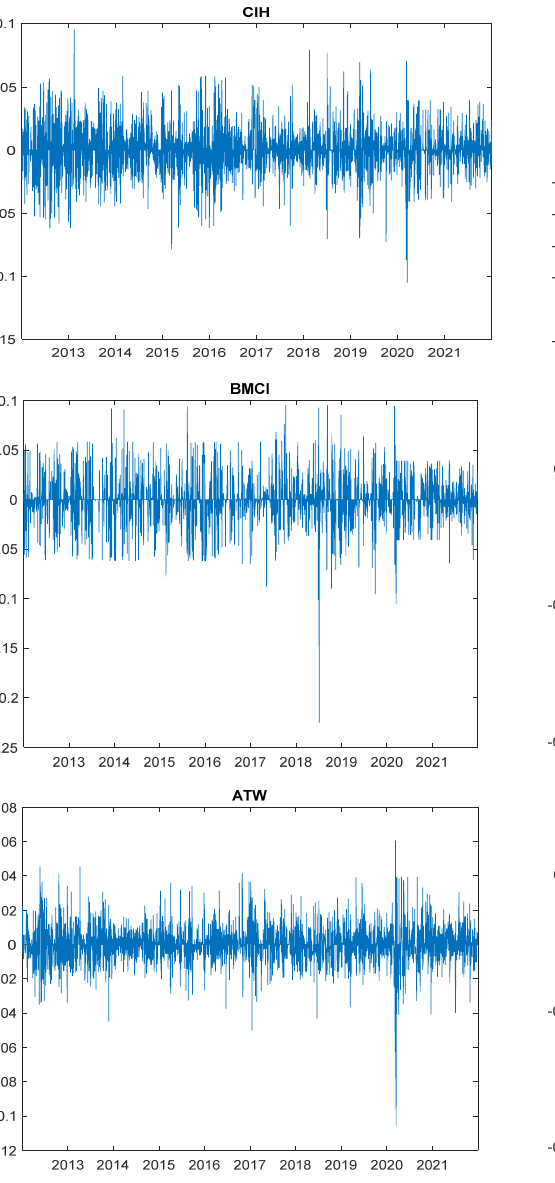
Figure 4. Daily returns on bank shares before and during the COVID-19 crisis.